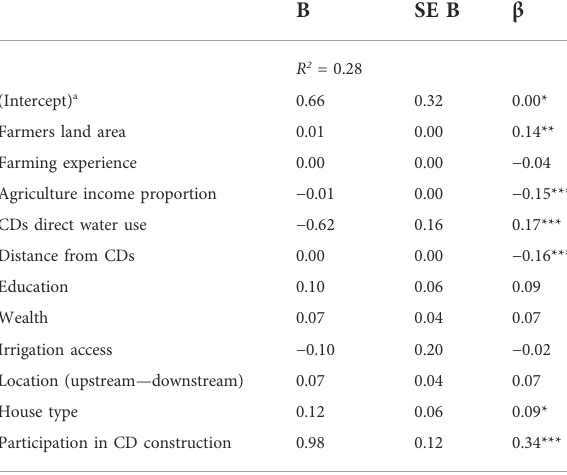
TABLE 3 Results of forced entry regression on contextual